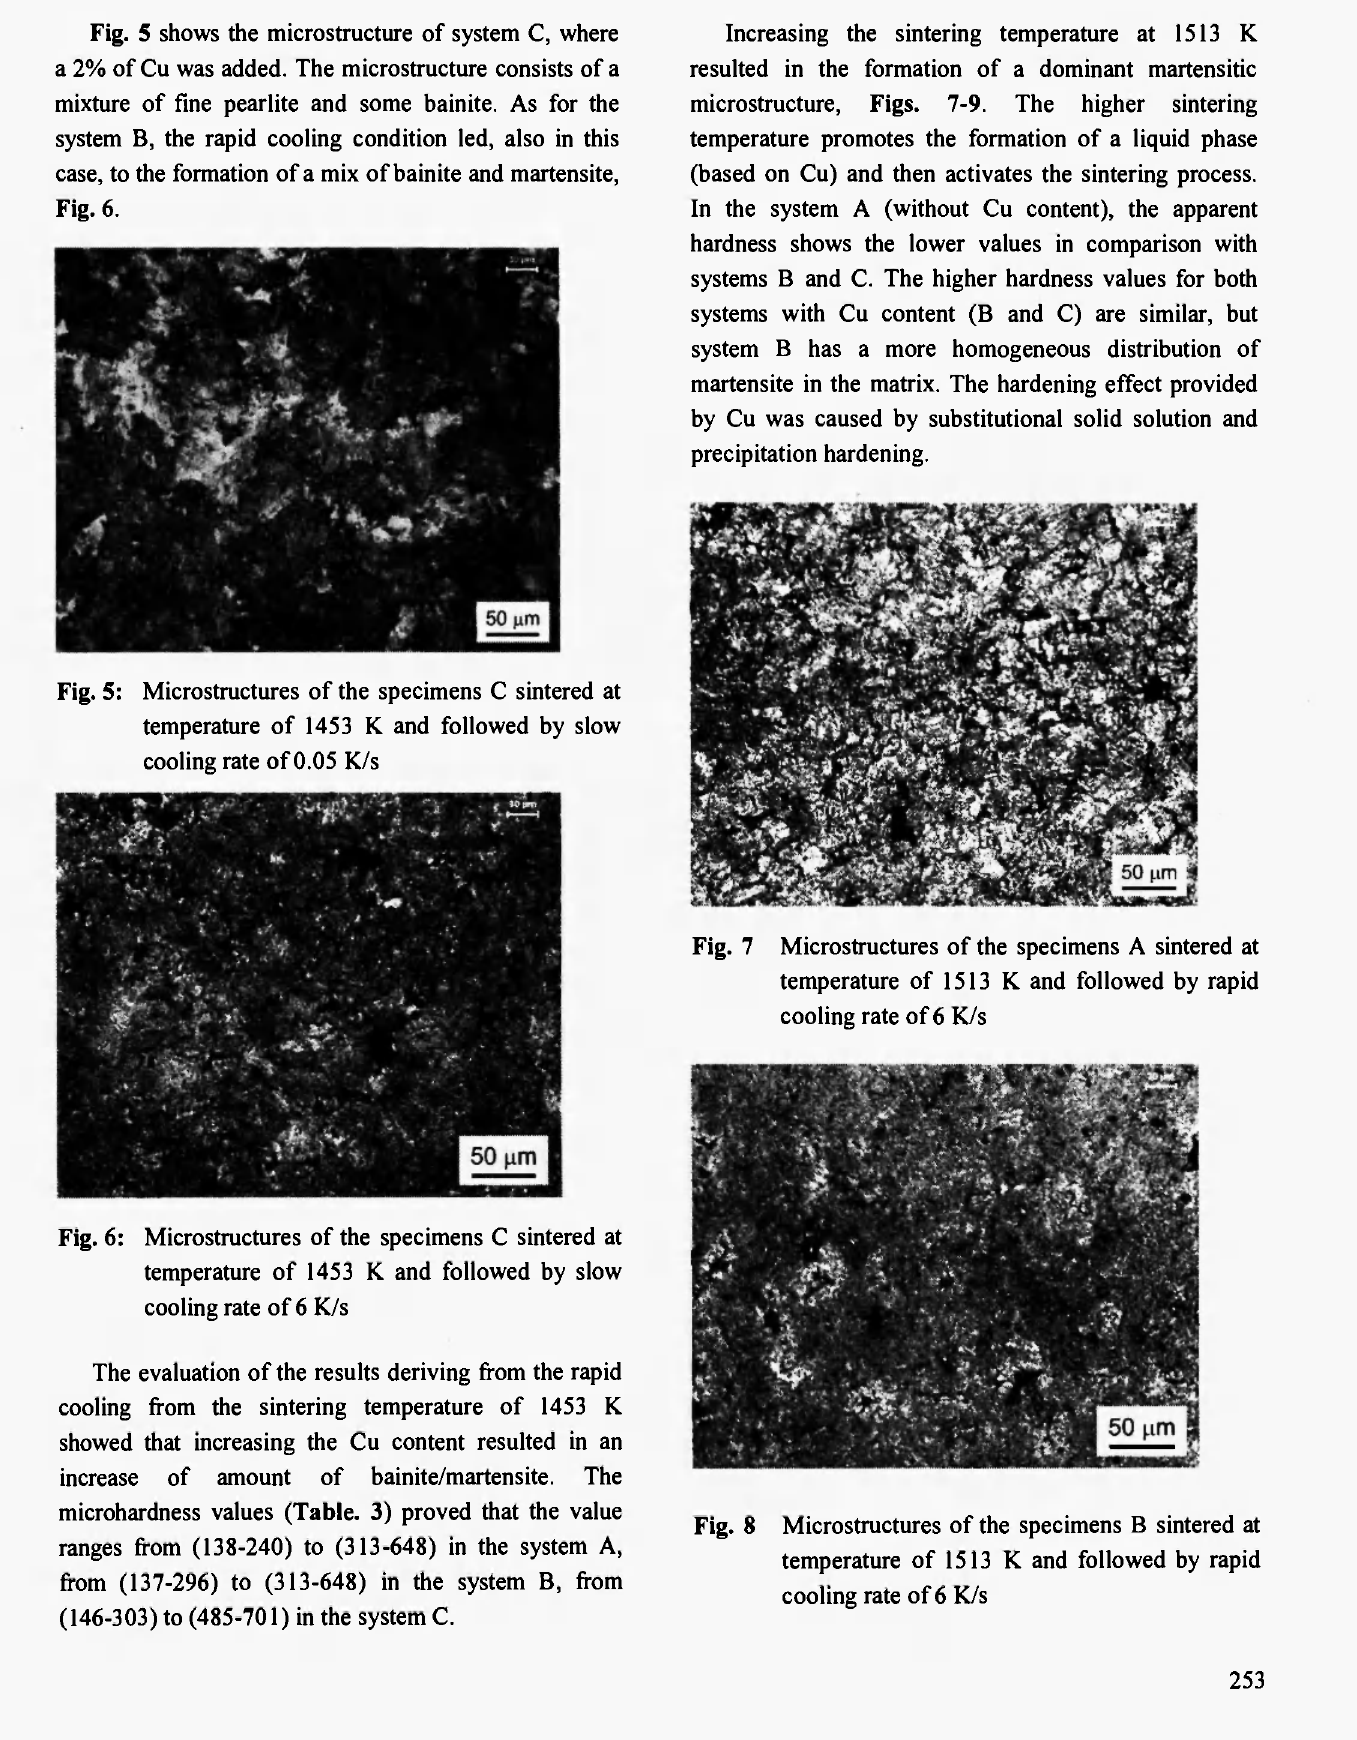
Fig. 6: Microstructures of the specimens C sintered at temperature of 1453 Κ and followed by slow cooling rate of 6 K/s